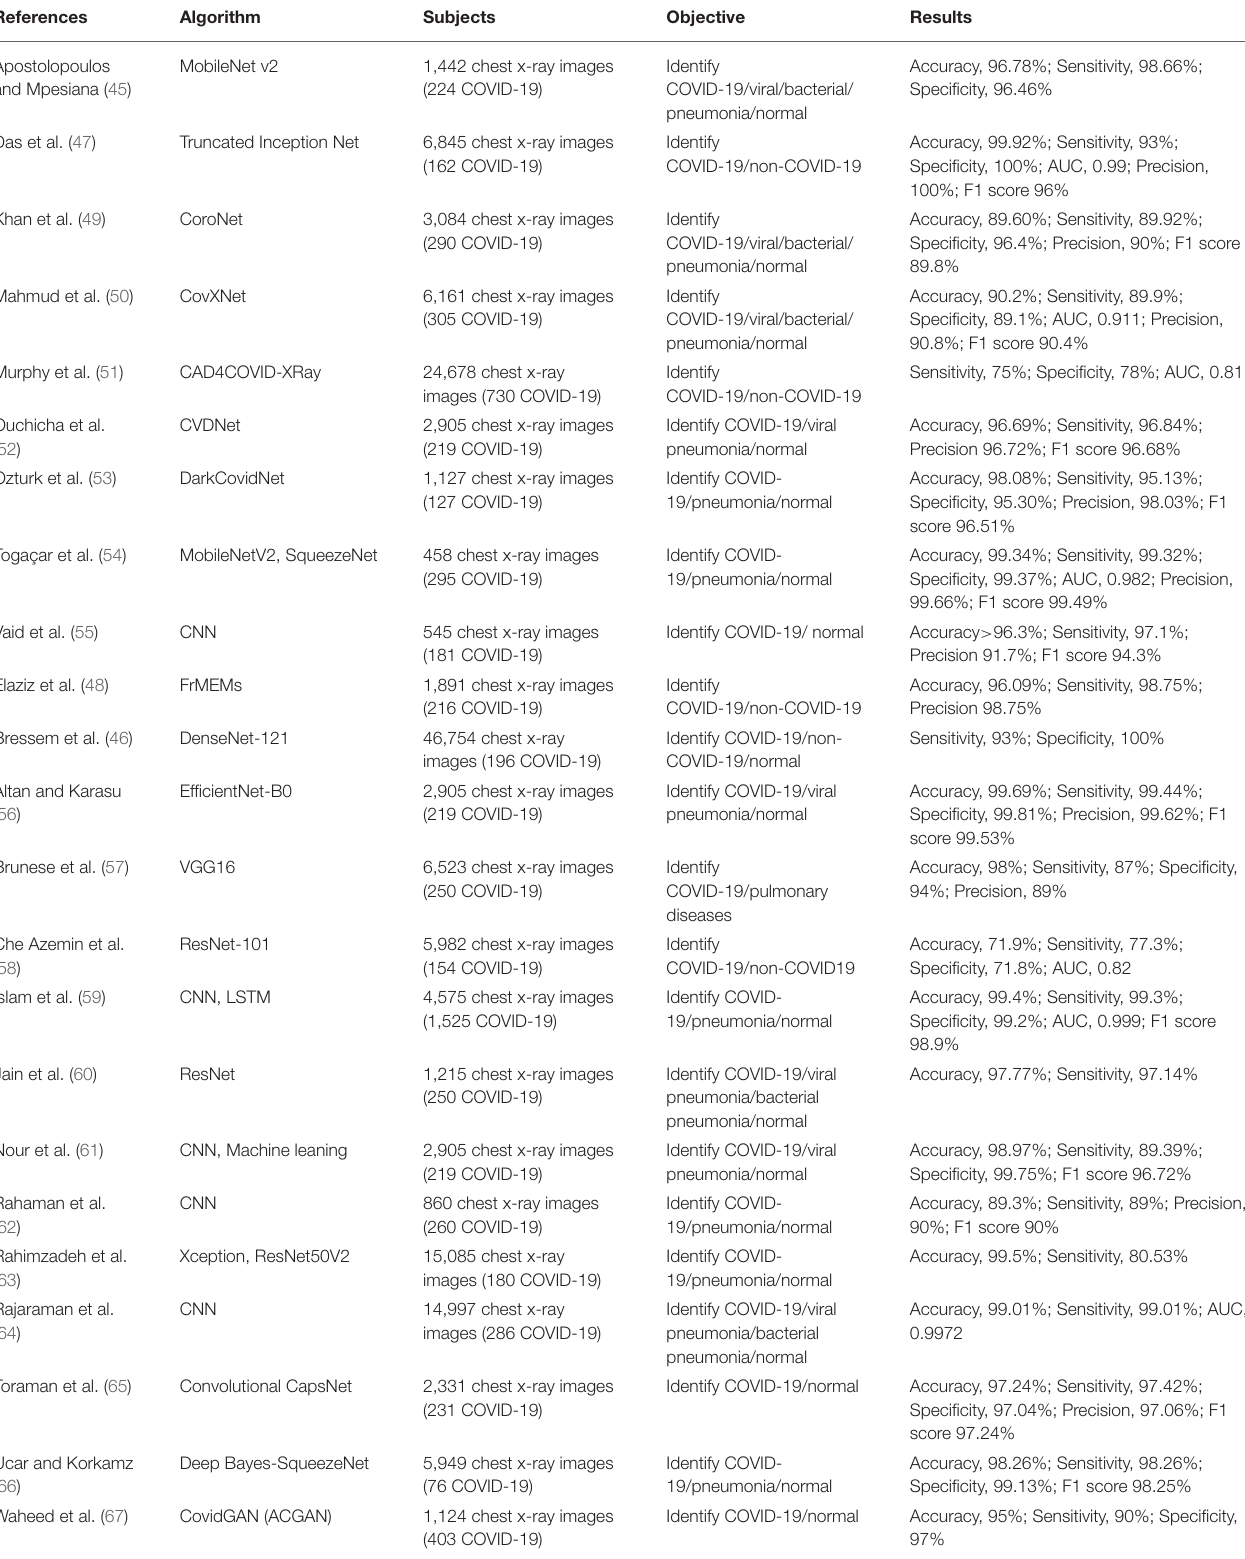
TABLE 3 | Application of AI in using chest x-ray images to diagnose